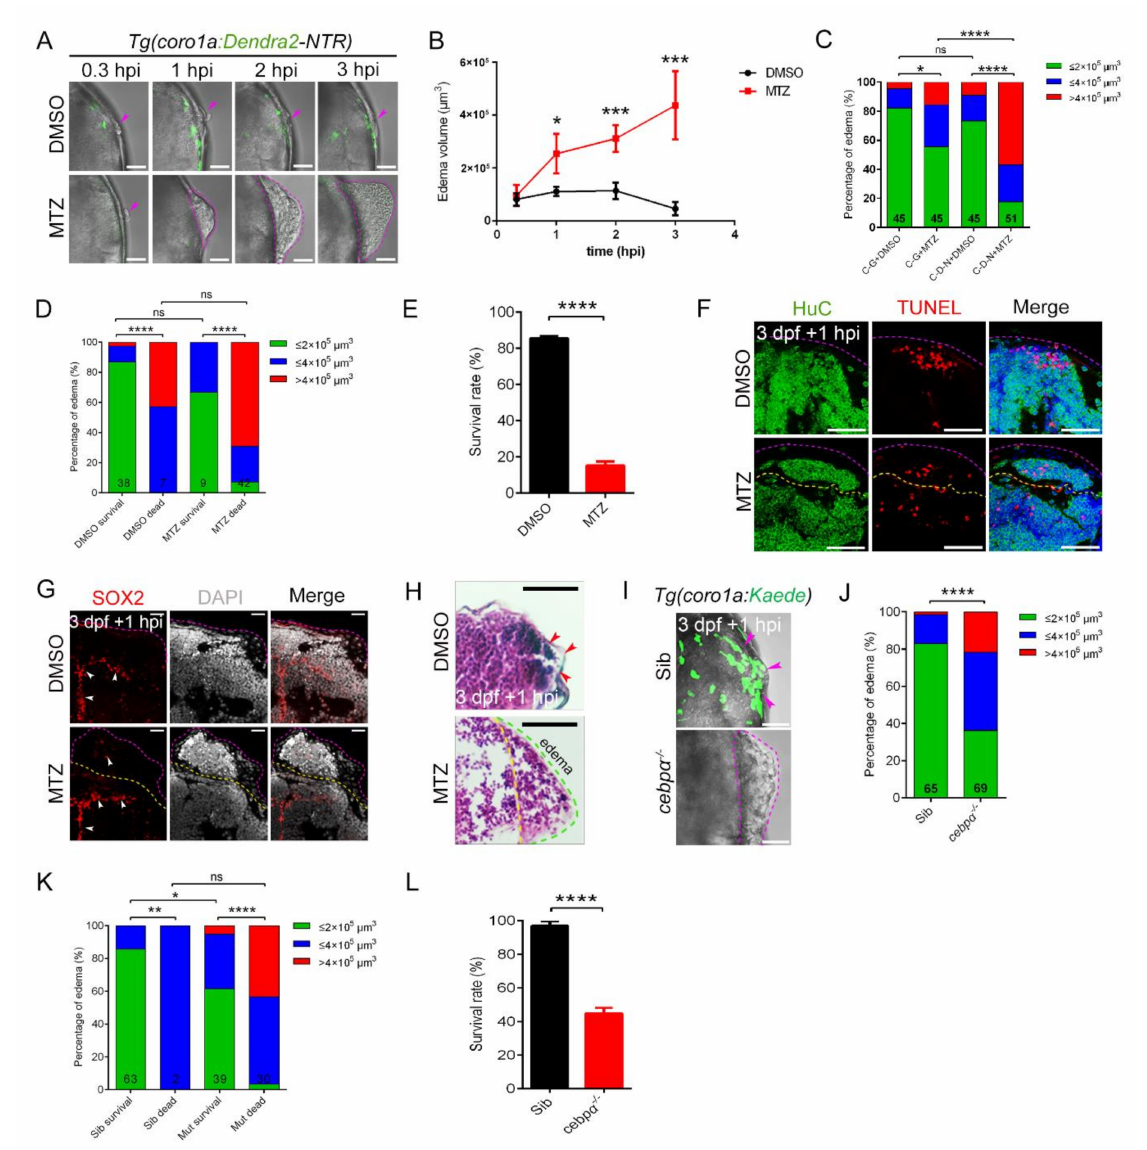
Figure 5. The absence of macrophages led to the development of brain edema. ( A ) Phenotypes of edema-like symptoms at different time points after injury. Scale bar, 50 µ m. ( B ) Statistics of edema volume in ( A ). ( C ) Statistics of edematous symptoms in Tg(coro1a:Dendra2—NTR) (C-D-N) and Tg(coro1a:GFP) ( C – G ) with DMSO/MTZ treatment. Purple arrowheads indicate the injury sites. ( D ) Analysis of zebrafish survival and edematous symptoms in Tg(coro1a:Dendra2-NTR) with DMSO/MTZ treatment after injury. ( E ) Survival rate of Tg(coro1a:Dendra2-NTR) with DMSO/MTZ treatment at 1 dpi. ( F ) The fluorescent images of HuC + and TUNEL + signals in edematous overflow. The purple dotted line represents the lateral edge of the edema and the yellow dotted line represents the internal measurement edge of the edema. Scale bar, 50 µ m. ( G ) The fluorescent images of SOX2 + signals in edematous overflow. The red arrowheads indicate location of SOX2 + signals. Scale bar, 20 µ m. ( H ) Detection of brain tissue by H&E staining of paraffin sections after injury. Red arrowheads indicate the injury site. Scale bar, 50 µ m. ( I ) The bright field and fluorescent images of coro1a -Kaede + cells and edema-like symptoms (purple dashed line). Scale bar, 50 µ m. The purple arrowheads indicate the accumulation of macrophages at the wound site. ( J ) Statistics of edematous symptoms in cebp α mutant and sibling after injury. ( K ) Analysis of zebrafish survival and edematous symptoms in cebp α mutant and sibling after injury. ( L ) Survival rate of cebp α mutant and sibling at 1 dpi. (Data are shown as mean ± SEM. ns , no significance; *, p < 0.05; **, p < 0.01; ***, p < 0.001; ****, p <